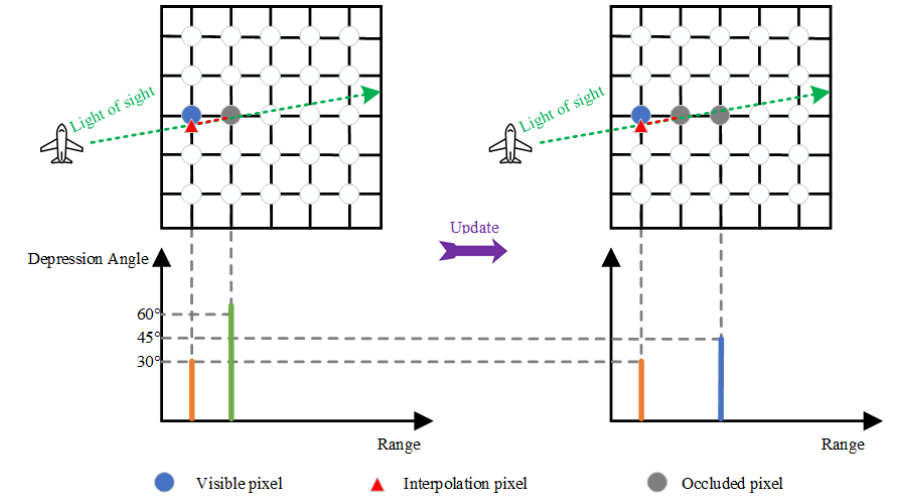
Figure 7. Schematic of the proposed depression angle updating algorithm.